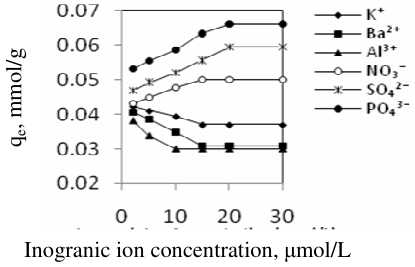
Figure 3. Plot of soium-palmitate adsorption in the presence of various inorganic lons at differeent concentrations and charges for galena